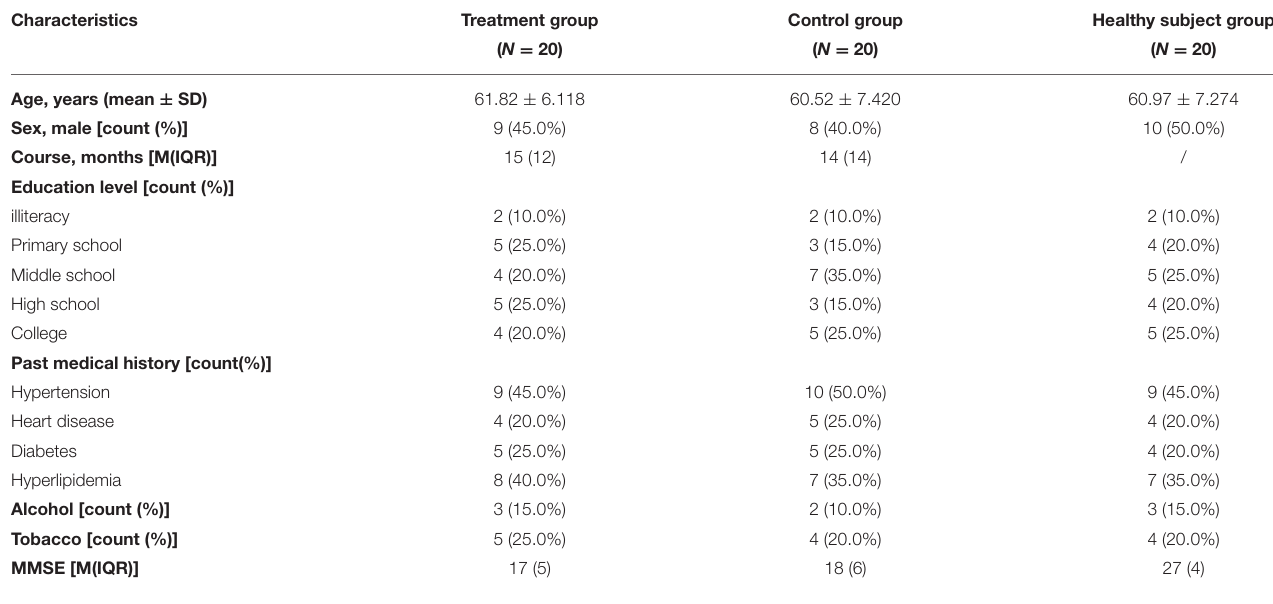
TABLE 1 | Baseline characteristics of